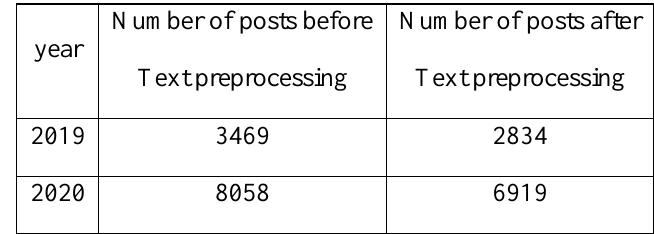
Table 4 number of Instagram posts in each year before and after text preprocessing